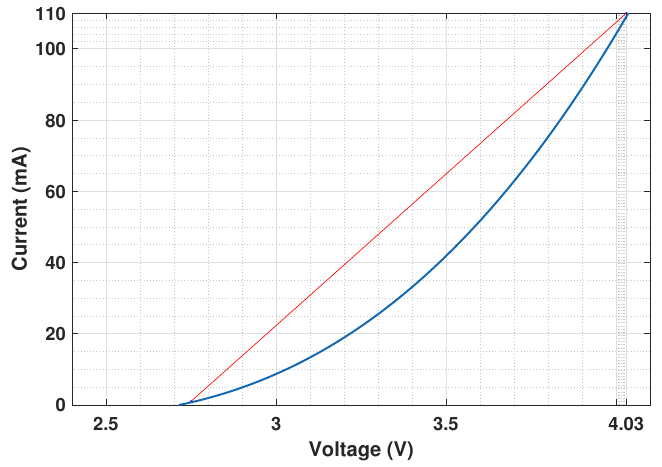
Figure 4. I-V characteristics of the LED [43]. Blue curve: real characteristic; red line: approximate linearized characteristic with V min = 2.75V, V max = 4.03V, I min = 1mA, I max =